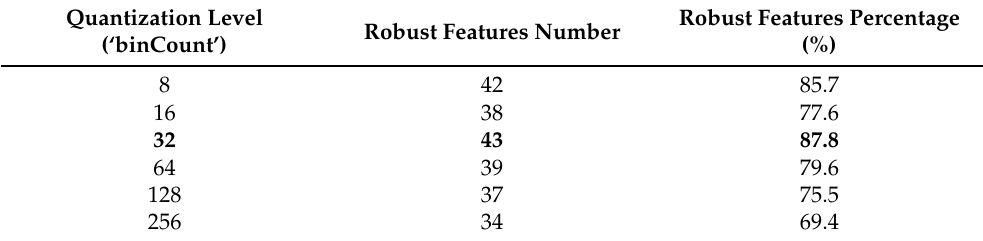
Table 3. Summary of robust features (ICC > 0.9) considering different quantization levels. Bold values represent the setting guaranteeing the maximum number of robust features.